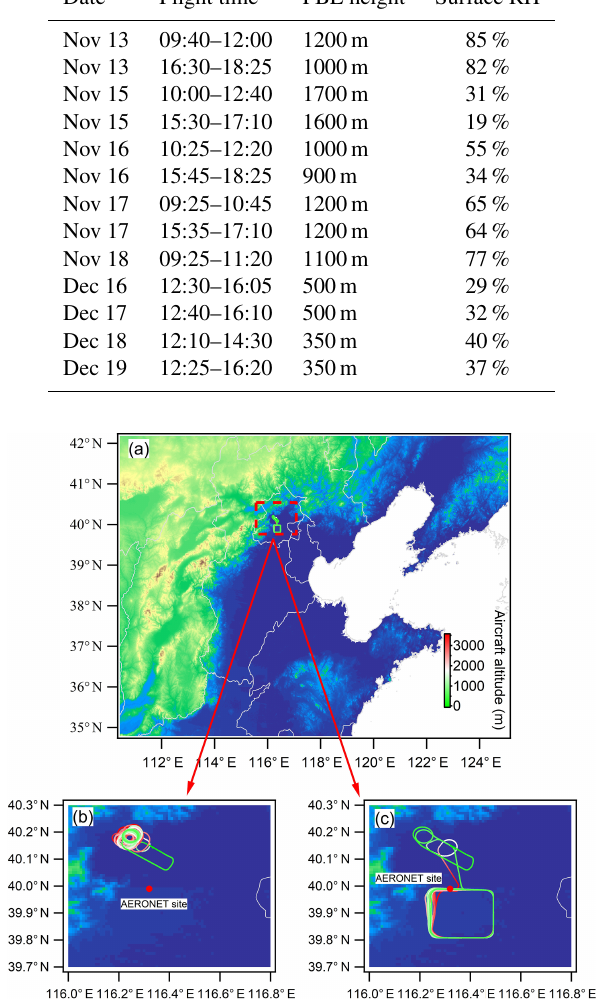
Figure 1. Flight tracks on the terrain map. (a) The surrounding terrain and (b) flight tracks in November 2016 and (c) in Decem- ber 2016. Red solid symbols in (b) and (c) represent the location of the Peking University AERONET